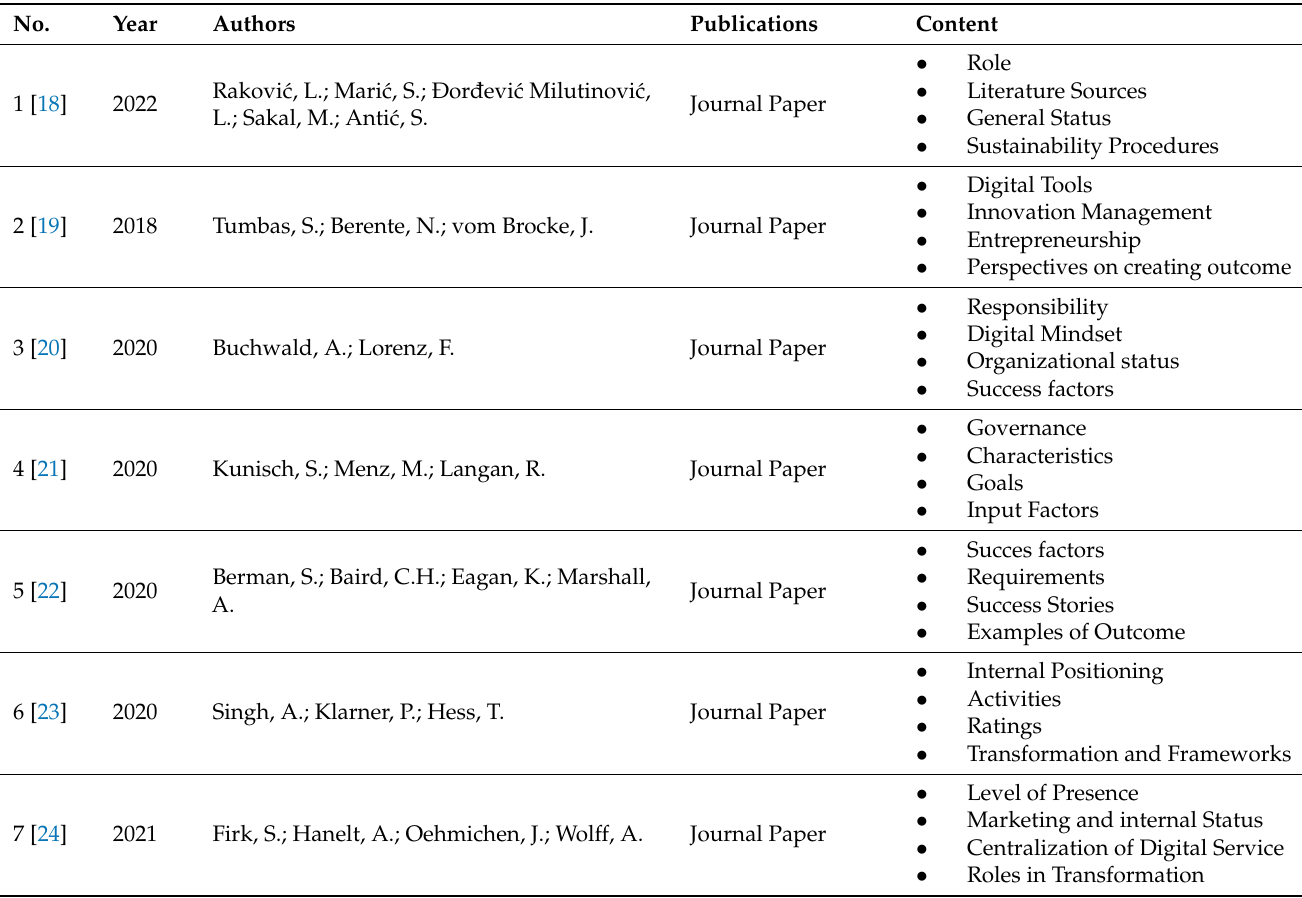
Table 1. List of papers with special relation to the research